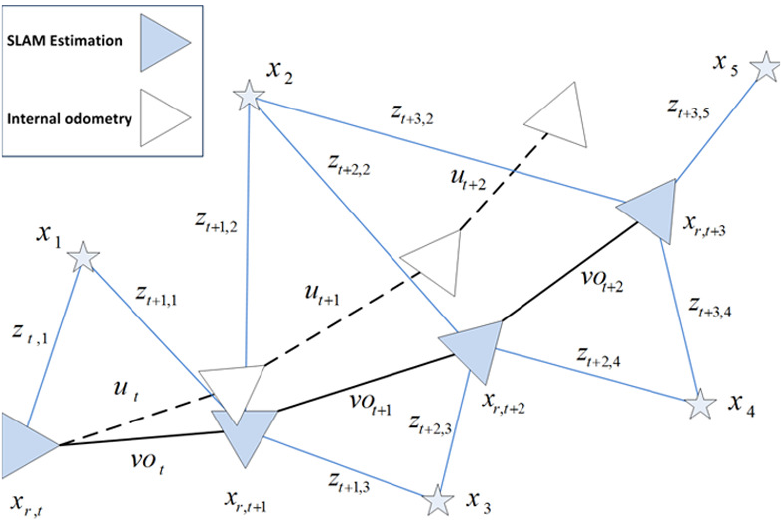
Figure 7. Graph-diagram of the view-based SLAM system. Colored items represent the estimation of the pose of the robot ( x r , t ), at each t . Blank items represent the internal odometer estimation, u t . A set of observed views in the map, x n , are also indicated. The prior for the next SLAM state is defined by our omnidirectional visual odometry, vo t . The observation measurement to the views are expressed by z t , n